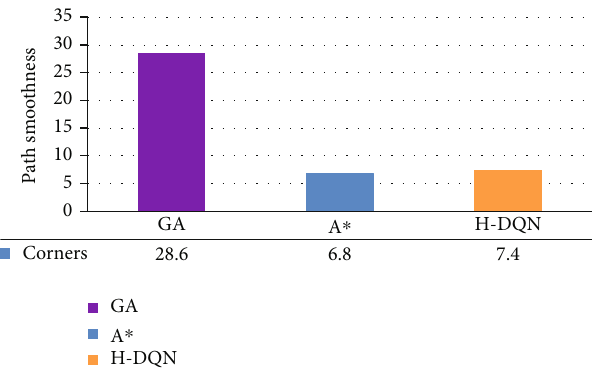
Figure 12: Comparison of path smoothness obtained for GA, A ∗ , and H-DQN